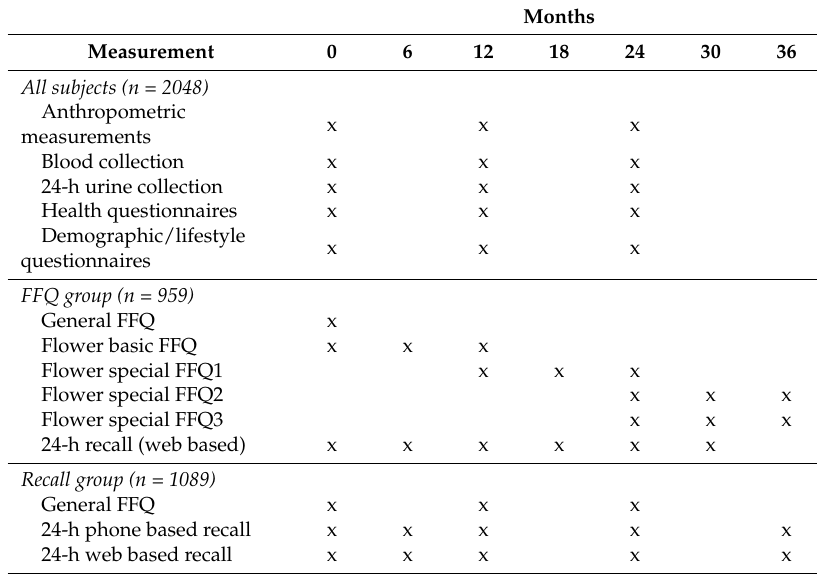
Table 1. Overview of measurements of the National Dietary Assessment Reference Database (NDARD)